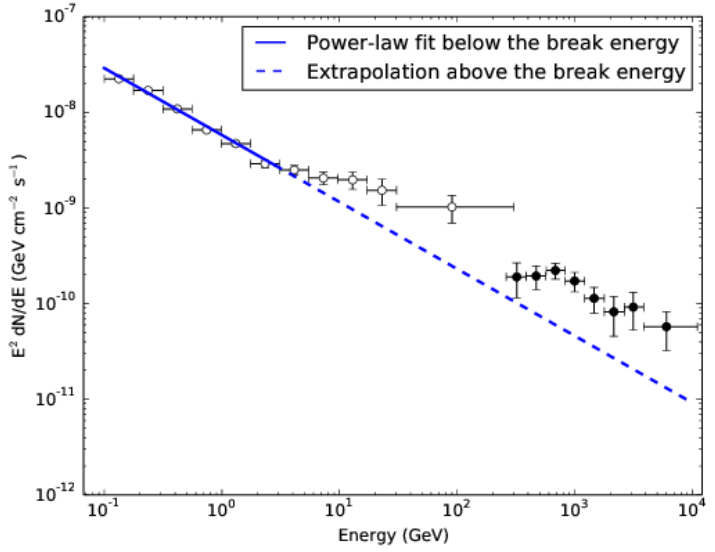
Figure 3. The gamma-ray core spectrum of Cen A above 100 MeV based on 8 year of Fermi-LAT and more than 200 h of H.E.S.S. data. The spectrum shows an unusual spectral hardening at E b (cid:39) 2.8 GeV, with photon index changing by ∼ 0.4 ± 0.1 (assuming a broken power law), see Ref. [38] for details. This spectral feature is most naturally attributed to a second emission component that emerges towards highest energies and that allows to smoothly connect the HE emission (above E b ) with the VHE